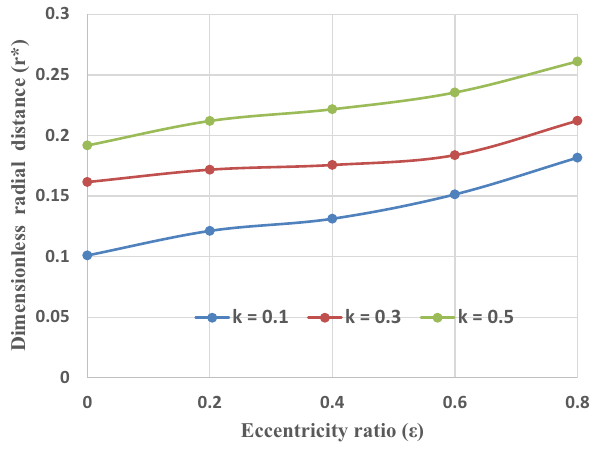
Fig. 7 Variation of the critical transition spot (r*) with eccentricity ratio (ε) for different radius ratio (k) for plane P4